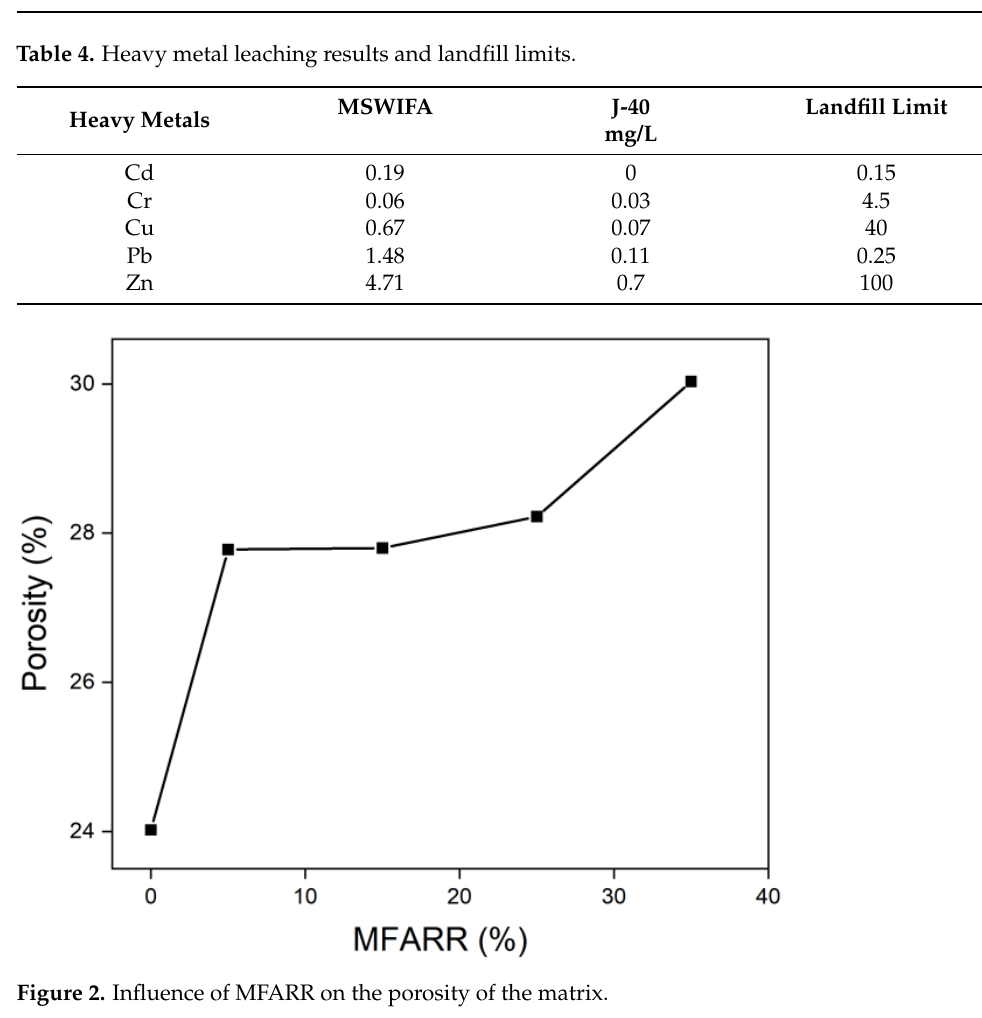
Figure 2. Influence of MFARR on the porosity of the matrix.